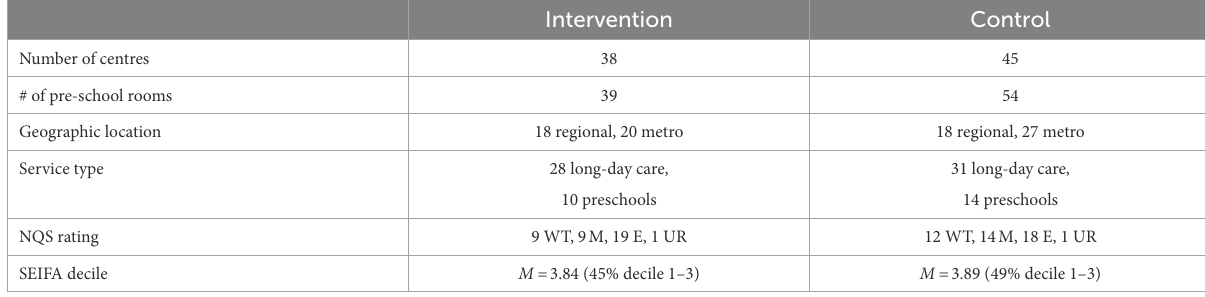
TABLE 1 Final sample centre characteristics by